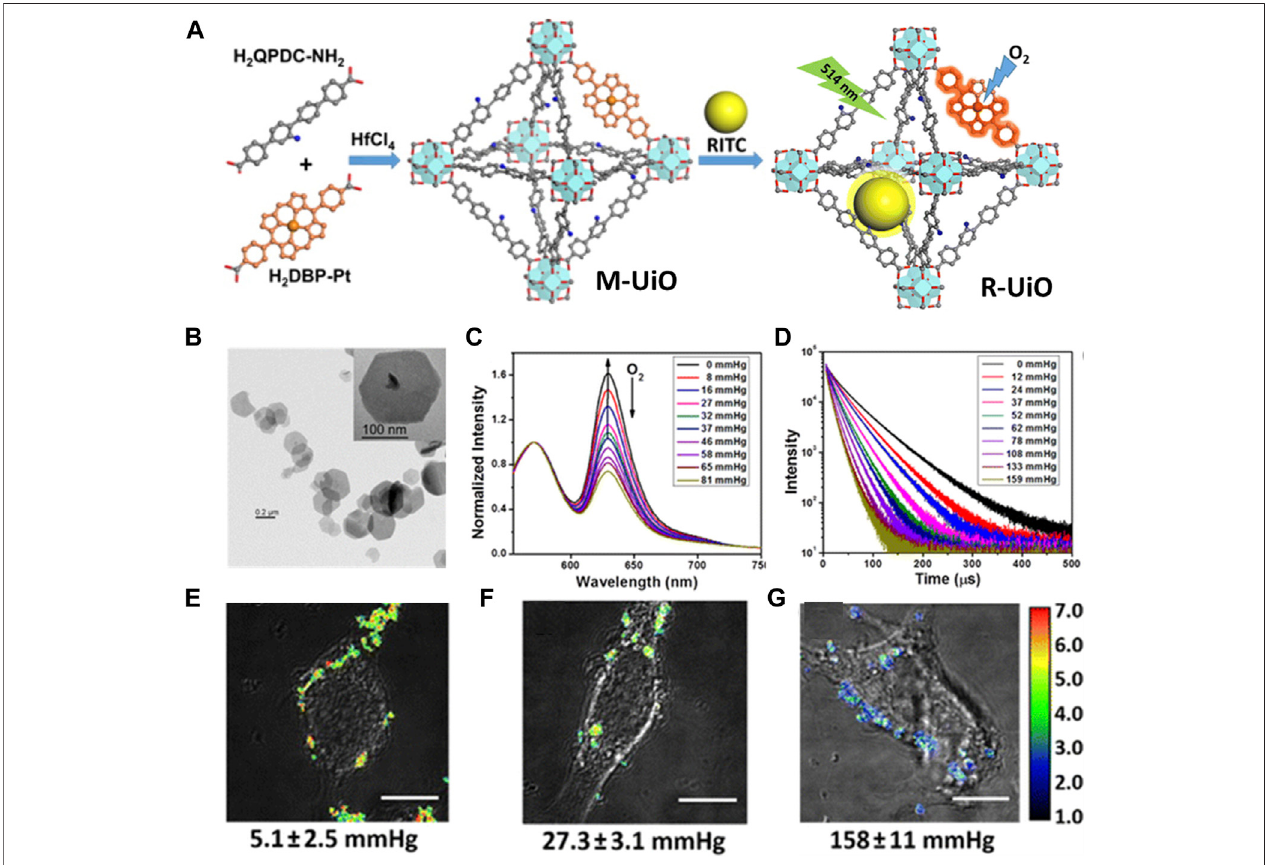
FIGURE 8 | (A) The schematic illustration of synthesis process of mixed-ligand M-UiO NMOF and R-UiO NMOF; Schematic illustration of R-UiO NMOF offers oxygen generation under 514 nm light irradiation. (B) TEM images of R-UiO. (C) Emission spectra ( λ ex (cid:1) 514 nm) and (D) phosphorescent decays ( λ ex (cid:1) 405 nm) of R-UiO-1inHBSS buffer undervarious oxygenpartialpressures.Ratiometricluminescenceimaging( λ ex (cid:1) 514 nm)ofCT26 cellsafterincubationwithR-UiO-2under (E) hypoxia, (G) normoxia, and (F) aerated conditions. Scale bar: 10 μ m. Source: (Xu et al., 2016).